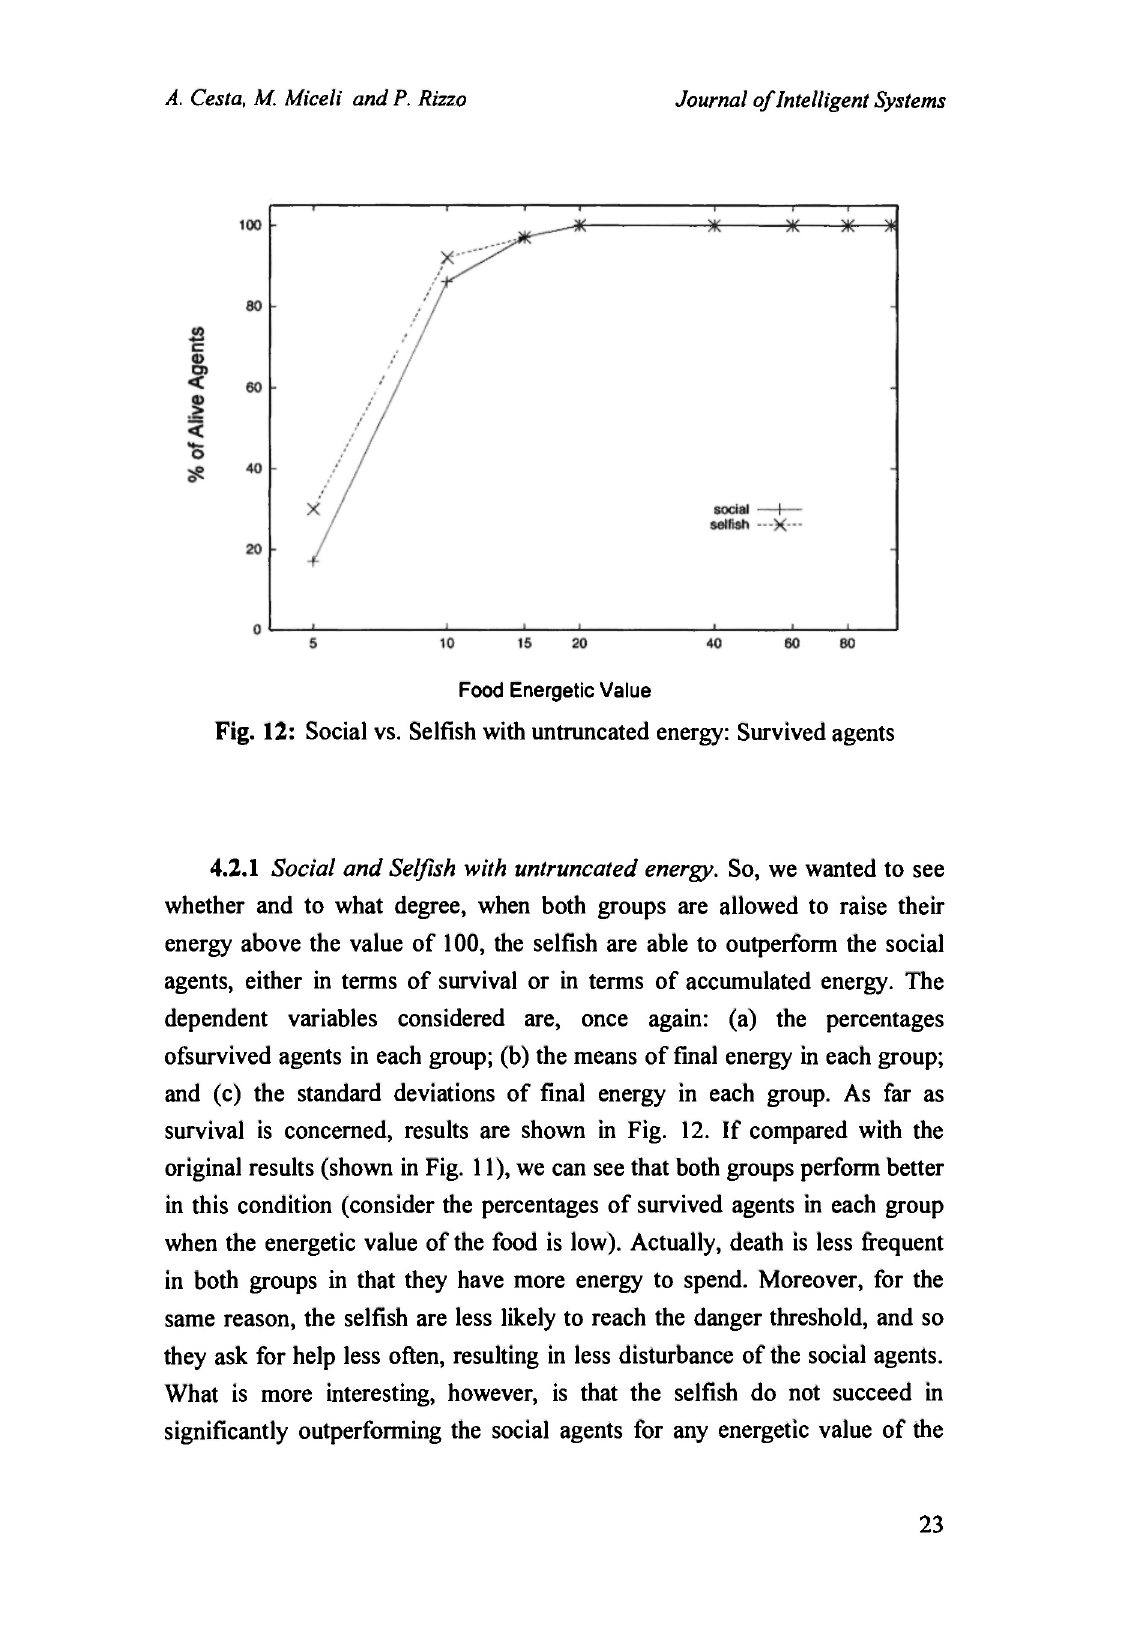
Fig. 12: Social vs. Selfish with untruncated energy: Survived agents